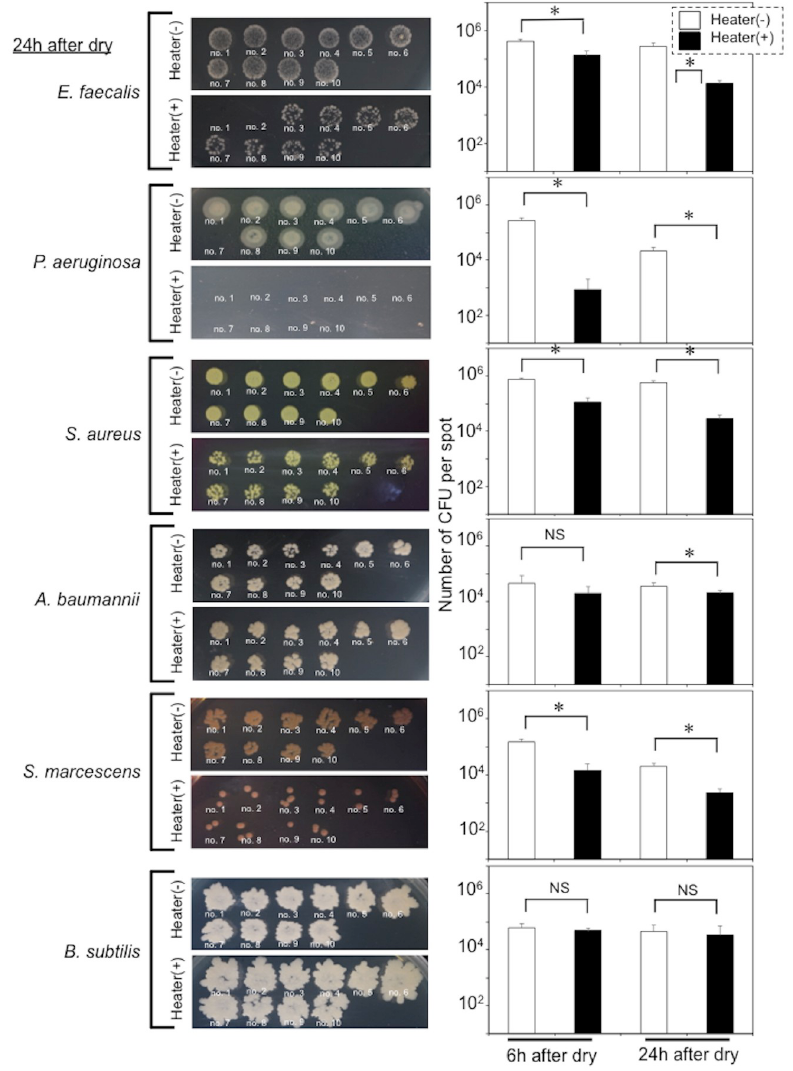
Fig 6. Handrail device warmed to human body core temperature prohibited the prolonged survival of other bacteria without spore formation on a stainless steel surface. The other bacteria ( E . faecalis , S . aureus , P . aeruginosa , A . baumannii , S . marcescens and B . subtilis ) were used for this study (see the Materials and methods). Images obtained at 24 h after drying correspond to representative bacterial images showing the effect of thermal control on survival of each of the bacteria on the handrail device. Numbers (1–10) indicate bacterial spots. Graphs (right) show a comparison of the bacterial CFU numbers on the stainless steel device with [Heater(+)] and without the heater [Heater(-)]. Black and white bars show the CFU values for the device with and without the heater. � , p < 0.05 between the bars. NS, no significant difference.